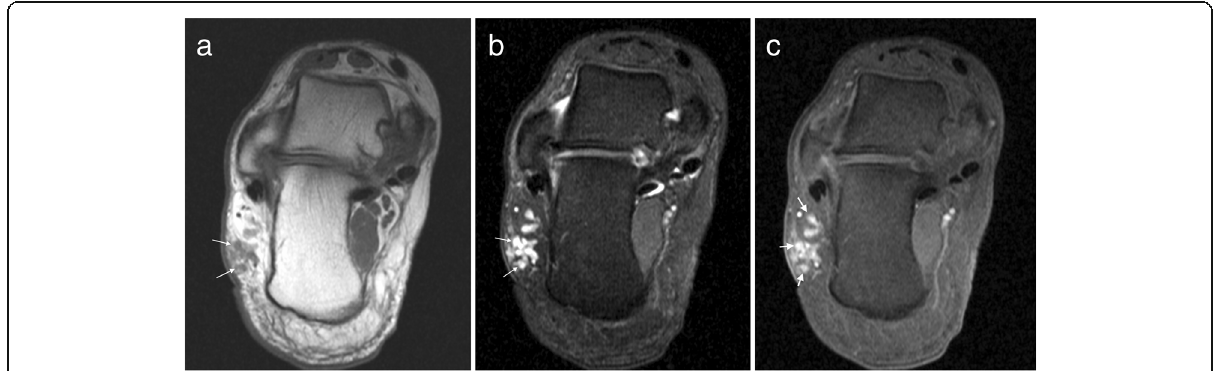
Fig. 3 Vascular malformation. a Axial T1W and ( b ) proton density with fat suppression (PDFS) images of the ankle demonstrating a low flow vascular malformation overlying the lateral aspect of the calcaneus with delayed multinodular enhancement (arrows) on the post contrast T1FS image ( c )